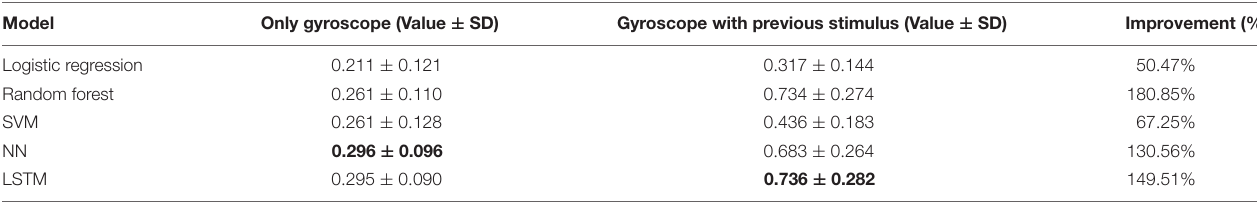
TABLE 7 | Performance in terms of “macro-F1” comparison between Logistic Regression, Random Forest, NN, and SVM with two feature sets.